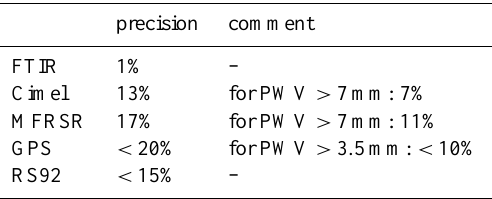
Table 6. Empirical estimation of the PWV data precision (GPS and RS92 values are conservative estimates since both experiments detect different airmasses as the FTIR